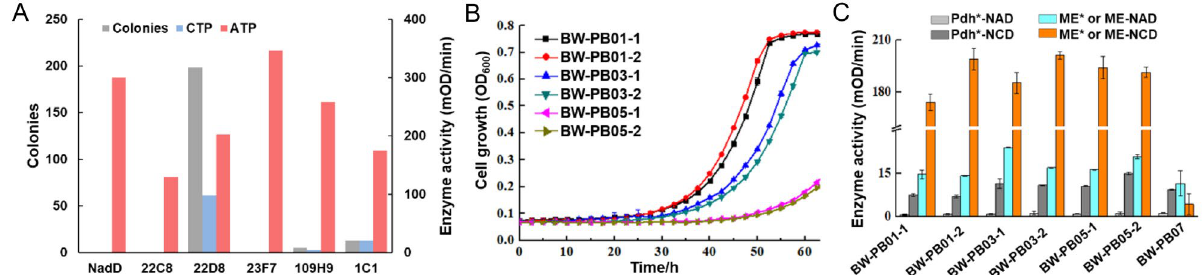
Figure 4. In vivo NCD synthesis supports E. coli growth. ( A ) Crude enzyme activities NadD mutants and number of colonies formed when transforming NadD variants. 22C8, 23F7, 109H9, 1C1, and 22D8 were NadD mutants formed during the directed evolution of NcdS. The data of crude enzyme activities was taken from the previous research 14 . ( B ) Growth characterization of engineered E. coli assembled with NCD-cycling pathway and NcdS in liquid minimal media with 5 mM phosphite as the sole phosphorous source. Data are the average of biological triplicates with standard deviations. ( C ) The crude enzyme activities of Pdh*, ME* and ME toward NAD and NCD. Experiments were conducted in triplicates, and data are presented as mean values. Pdh*-NAD, activity of Pdh* toward NAD. Pdh*-NCD, activity of Pdh* toward NCD. ME*or ME-NAD, activity of ME* or ME toward NAD. ME* or ME-NCD, activity of ME* or ME toward NCD. BW-PB01-1 and BW-PB01-2 had the same genotype, as well as BW-PB03-1 and BW-PB03-2, BW-PB05-1 and BW-PB05-2. BW-PB01, BW-PB03, and BW-PB05 expressed Pdh*, ME* and different NcdS. BW-PB07 expressed Pdh*, ME and